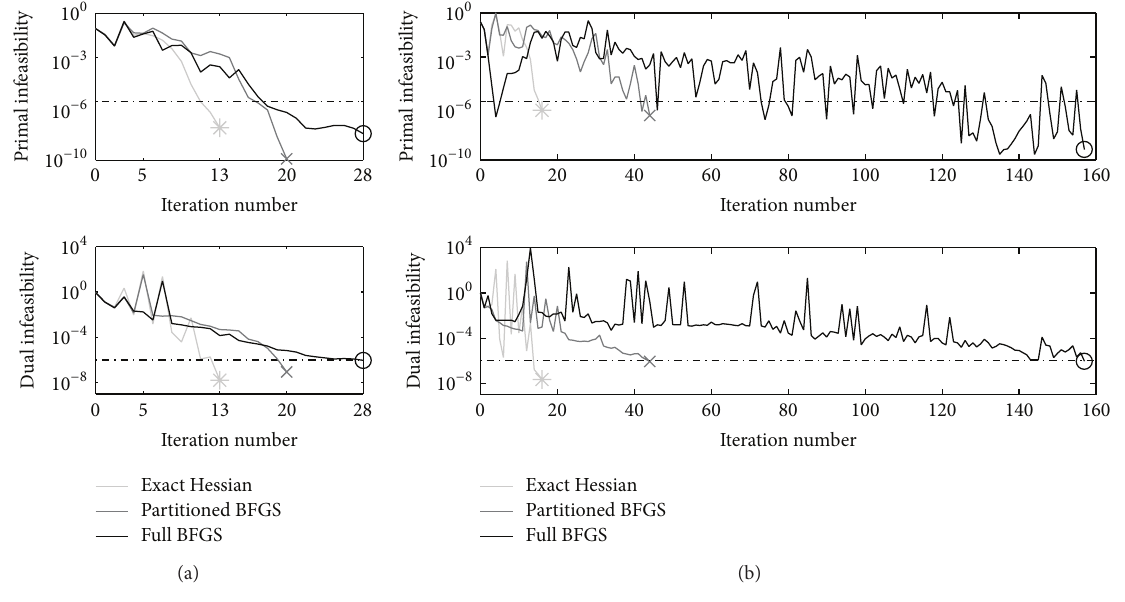
Figure 1: Convergence behaviour of IPOPT on the two test